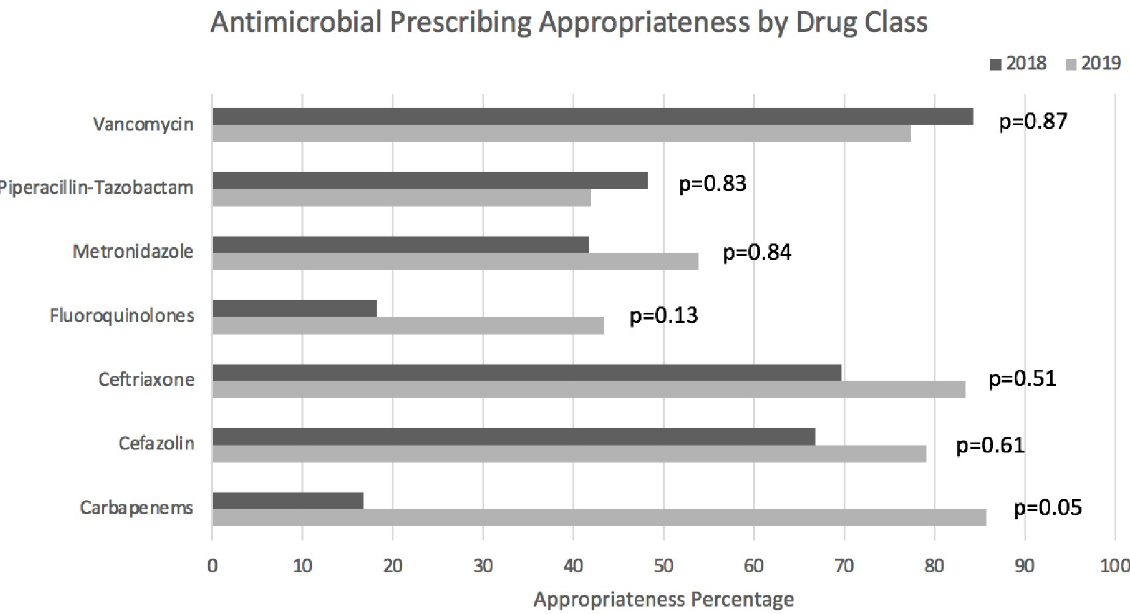
Fig 5. Antimicrobial prescribing appropriateness by drug class.